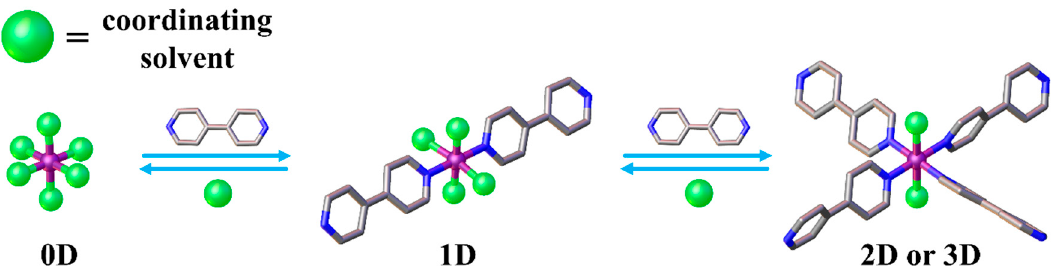
Figure 5. Scheme of the competing equilibria between the coordinating solvent and bridging ligand leading to different coordination polymers (CPs) through the coordinating solvent approach (CSA).